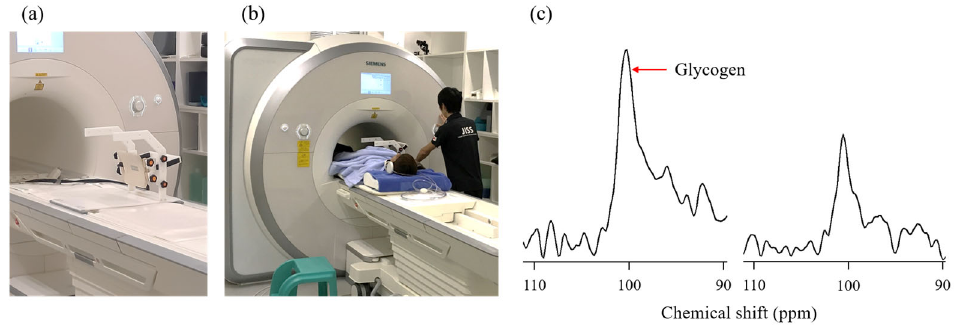
Figure 7. Muscle and liver glycogen measurements. ( a ) 13 C- 1 H double-tuned surface coil measuring 10 cm used for glycogen measurement. We used the same coils for both the muscle and liver. ( b ) View of 13 C magnetic resonance spectroscopy measurement of the liver. When measuring muscle glycogen levels, the coil was placed near the area concerned. ( c ) Example of muscle 13 C spectra pre-exercise (left) and post-exercise (right).